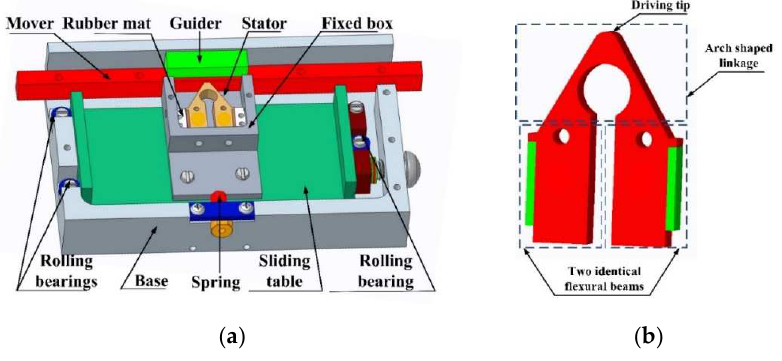
Figure 1. ( a ) Construction of the motor; ( b ) Stator structure.